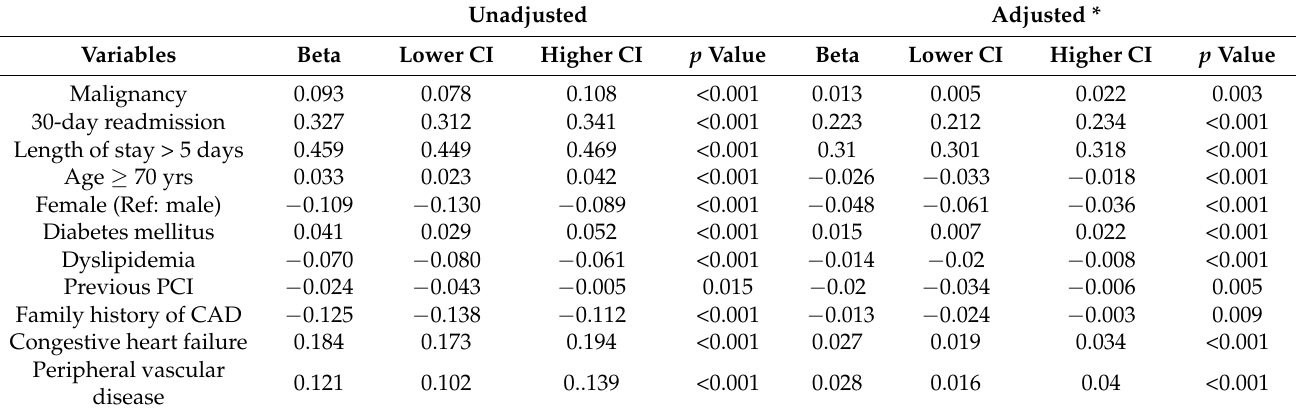
Table 4. Independent Predictors of Higher 30-Day Total Cost of Hospitalization in Patients with Takotsubo